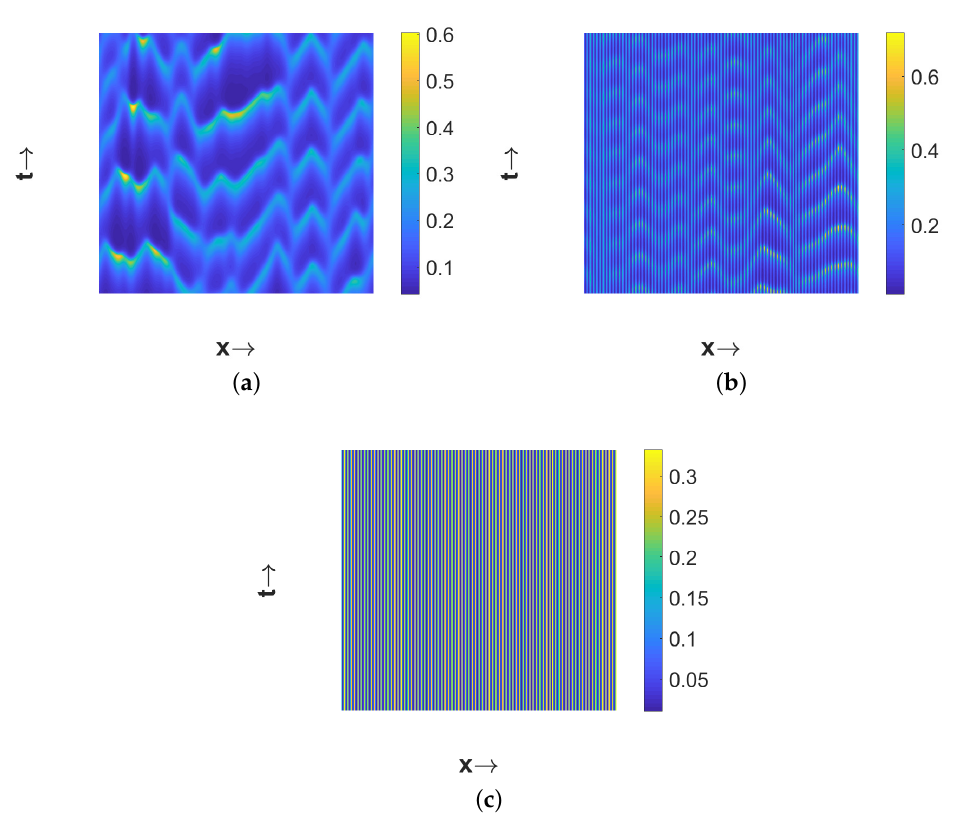
Figure 18. Plots of different types of patterns exhibited by u 1 representing the effect of the extent of nonlocality for (cid:101) = 8.0 and d 3 = 1.0. Three different patterns are obtained for ( a ) δ = 1.0; ( b ) δ = 2.0; ( c ) δ = 2.5. Other parameter values are the same as that of Figure